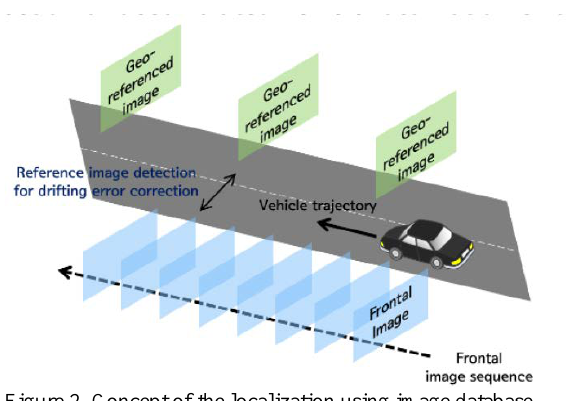
Figure 2. Concept of the localization using image database